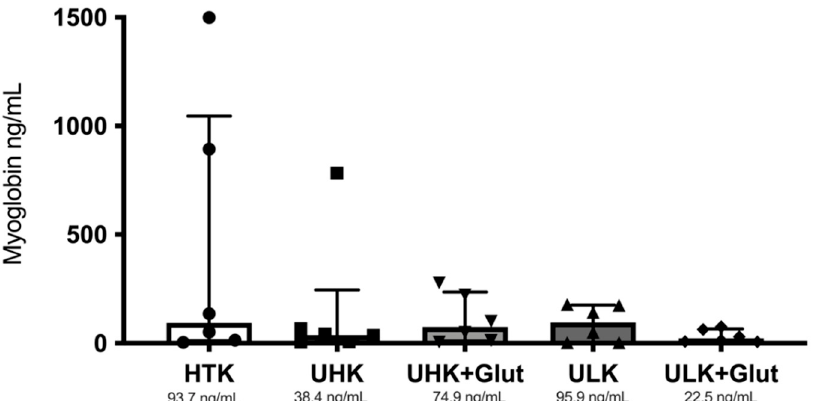
solution; UHK, Unisol-high-potassium; ULK, Unisol-low-potassium; Glut, glutathione.